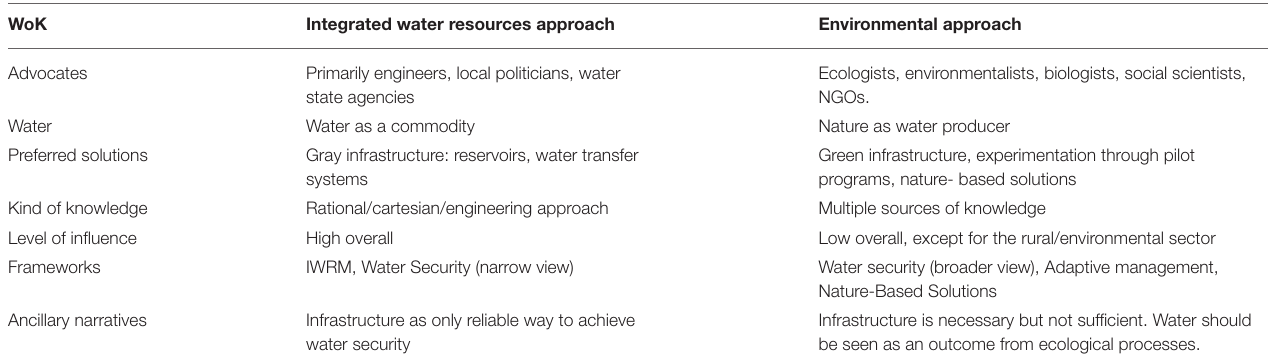
TABLE 1 | Ways of knowing and their main